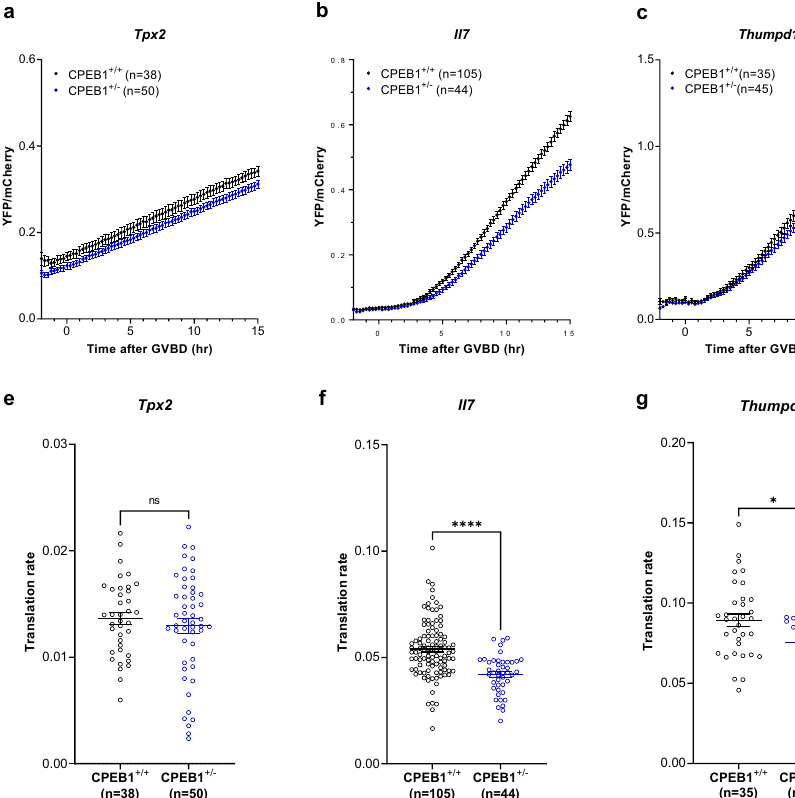
Fig. 9 | Haploinsuf fi ciency of CPEB1 recapitulates the decreased translation during oocyte maturation. GV oocytes from Cpeb1 +/+ ;Zp3Cre mice (CPEB1 +/+ oocytes) and Cpeb1 fl /+ ;Zp3Cre mice (CPEB1 +/ − oocytes) were injected with poly- adenylatedmCherry and YFP-Tpx2 3 ’ -UTR ( a , e ), YFP-Il7 3 ’ -UTR( b , f ), YFP-Thumpd1 3 ’ -UTR ( c , g ), or YFP-Golph3 3 ’ -UTR ( d , h ). After pre-incubation overnight, oocytes were released in the cilostamide-free medium for maturation. YFP and mCherry signals were recorded by time-lapse microscopy every 15min for 20h. The YFP signalswerenormalizedbythelevelofmCherrysignals. a – d YFP/mCherrysignalin